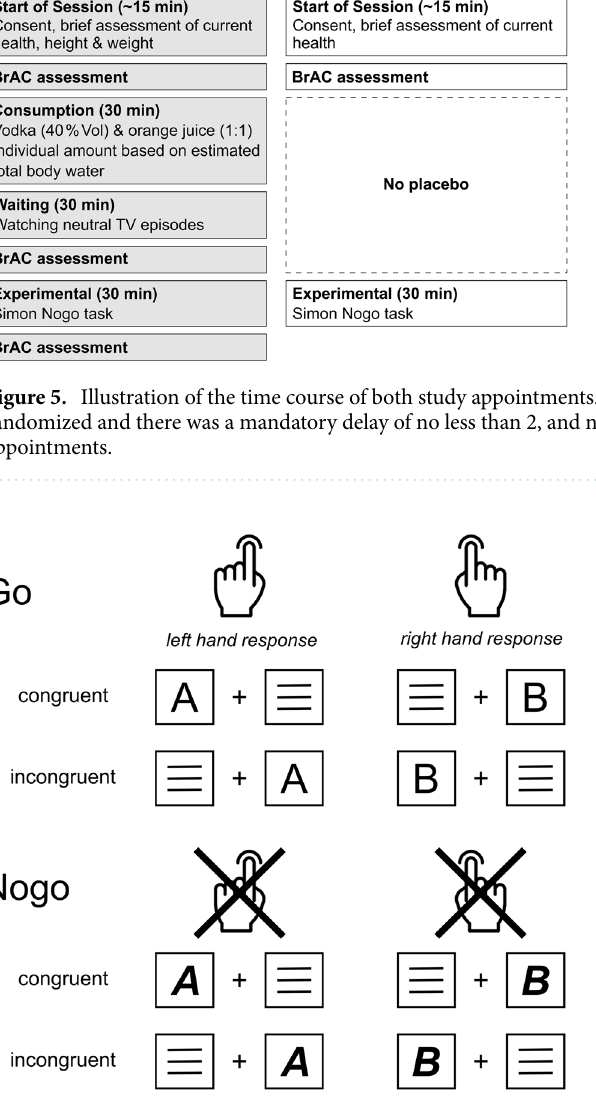
Figure 6. Illustration of the experimental paradigm. Go trials (see top panel) required a left hand response to the target stimulus “A” and a right hand response to the target stimulus “B”, irrespective of the side that they were presented on. Nogo trials (see bottom panel) were signaled by bold italic letters (“ A ” and “ B ”) and required the inhibition of all responses. Go trials were rated as “congruent” when target stimulus and responding hand were located on the same side, and rated as “incongruent” when they were located on contralateral sides. Nogo trials were labelled analogously to the Go trials, even though they did not require a motor